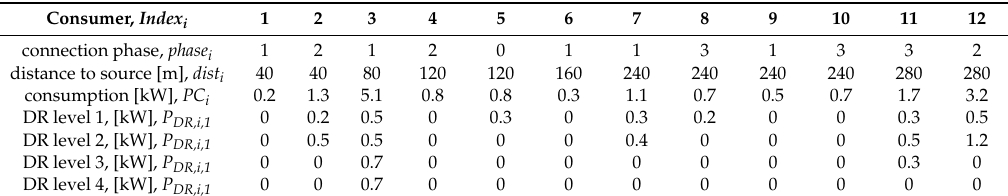
Table A2. An example of a DR solution encoding used by the MOPSO algorithm.